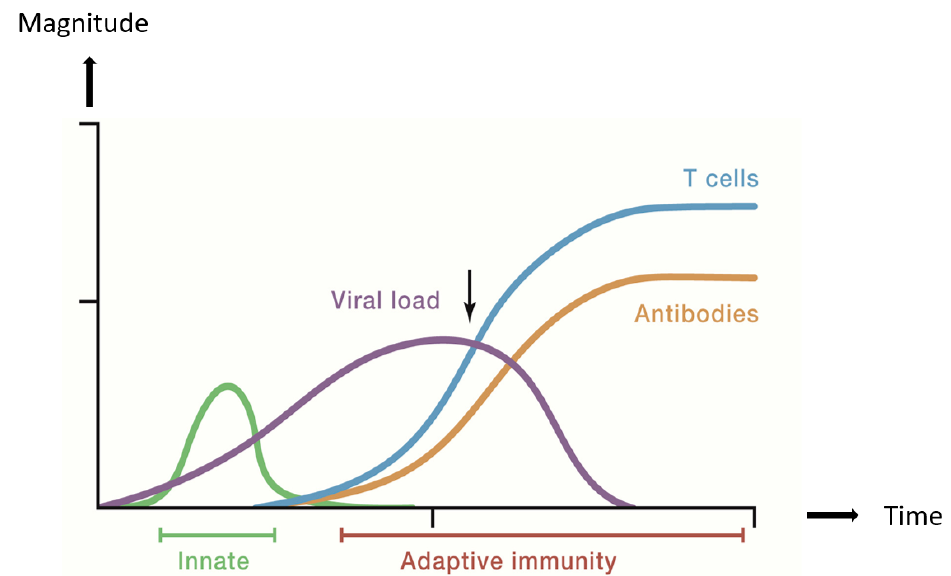
Figure 1. Generalized URT Immune Response and Viral Load in Mild COVID-19. Modified from Reference [16] with permission from Elsevier.